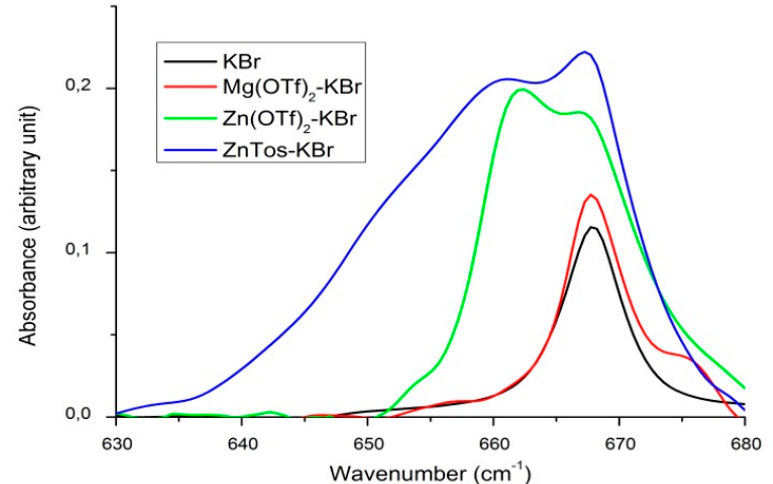
Figure 2. Infrared spectra of three selected catalysts dispersed in a KBr pellet, namely, ZnTos, Zn(OTf) 2 , and Mg(OTf) 2 under a CO 2 pressure of 4 MPa corrected from the contribution of the catalysts-loaded KBr pellet recorded under atmospheric pressure. The spectrum of a KBr pellet under CO 2 pressure at 4 MPa is reported for comparison.